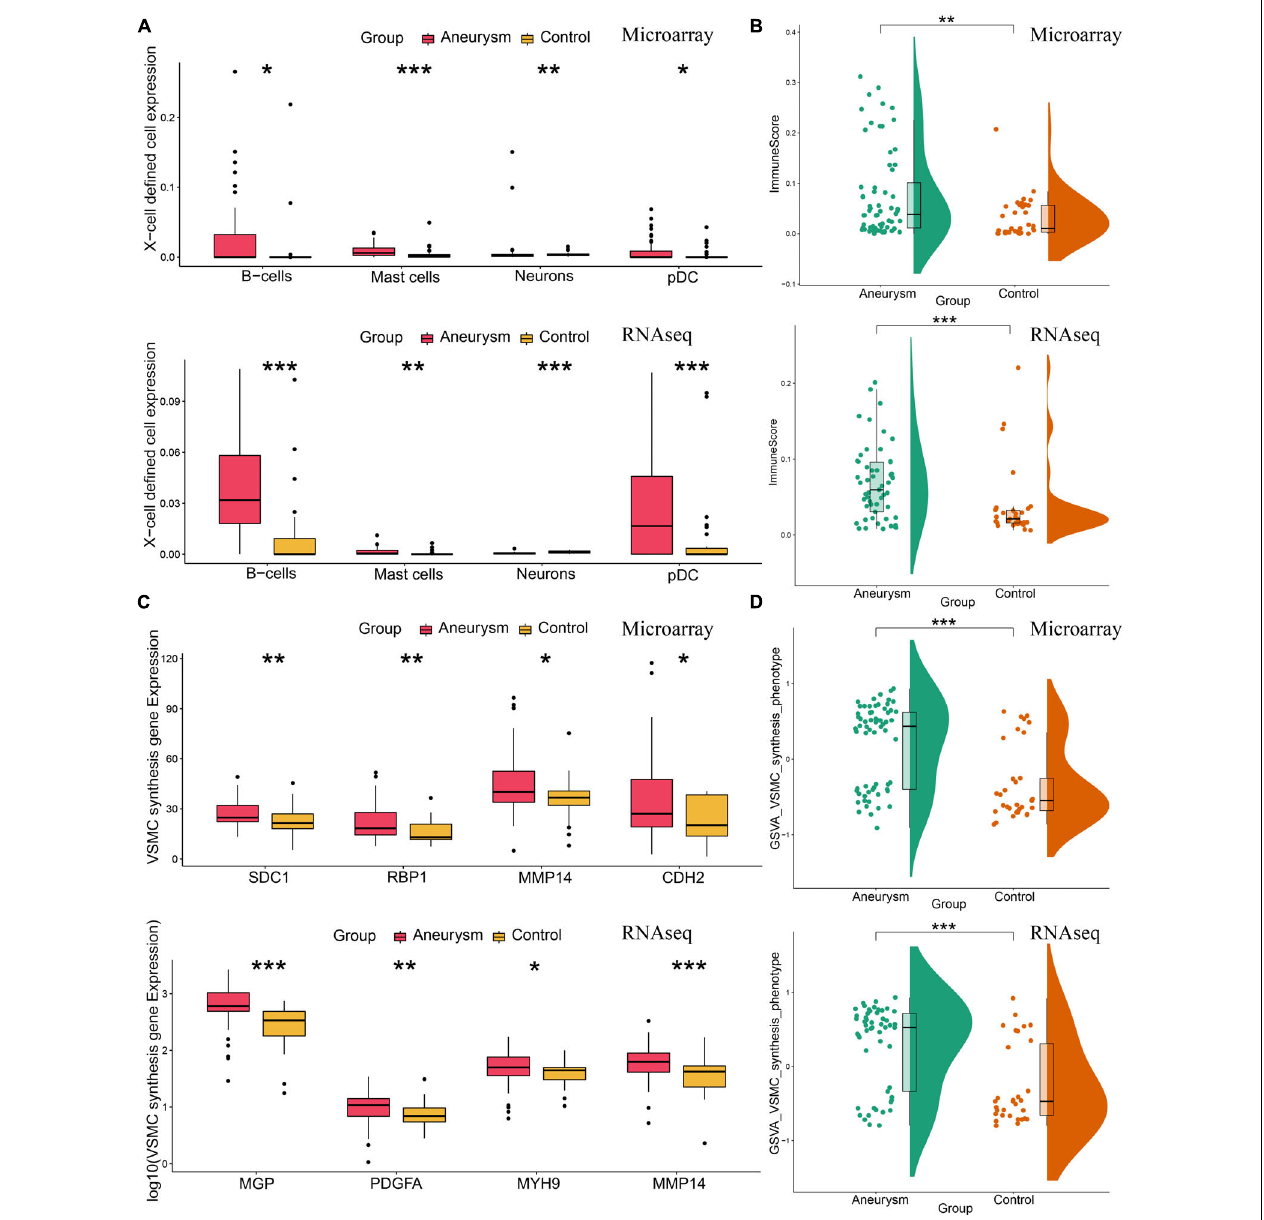
FIGURE 6 | Annotation of the arterial wall microenvironment of immune/inflammation infiltrating and VSMC phenotype in both training and validating cohorts. (A) The expression level of X cell-defined immunocytes and neurons. (B) The total enrichment scores of the immune microenvironment. IA lesions had higher immune expression than control arteries. (C) The expression of feature genes of VSMC synthesis phenotype. (D) The GSVA scores of VSMC synthesis phenotype. IA lesions had more VSMC synthesis phenotype than control arteries. * P < 0.05; ** P < 0.01; *** P <